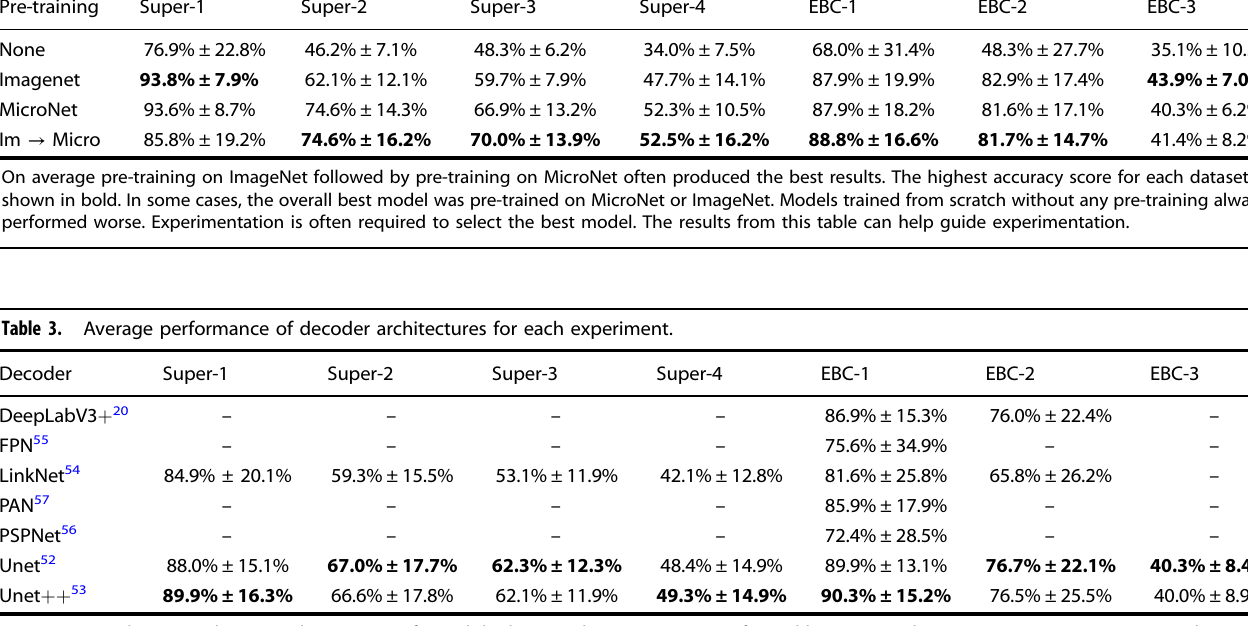
table can help guide experimentation to select the best model for a particular segmentation